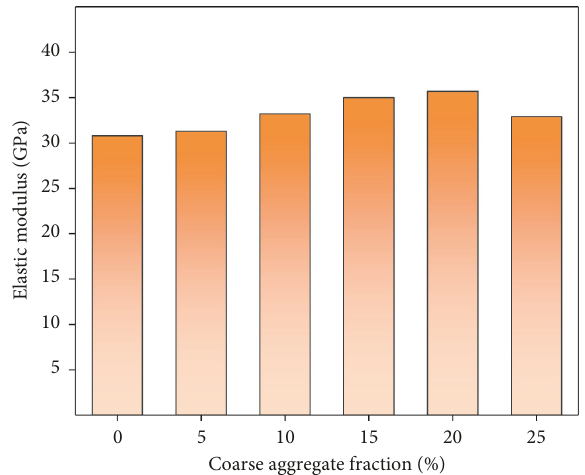
Figure 4: Elastic modulus of the coarse aggregate interlocking concrete subjected to different increasing amounts of coarse